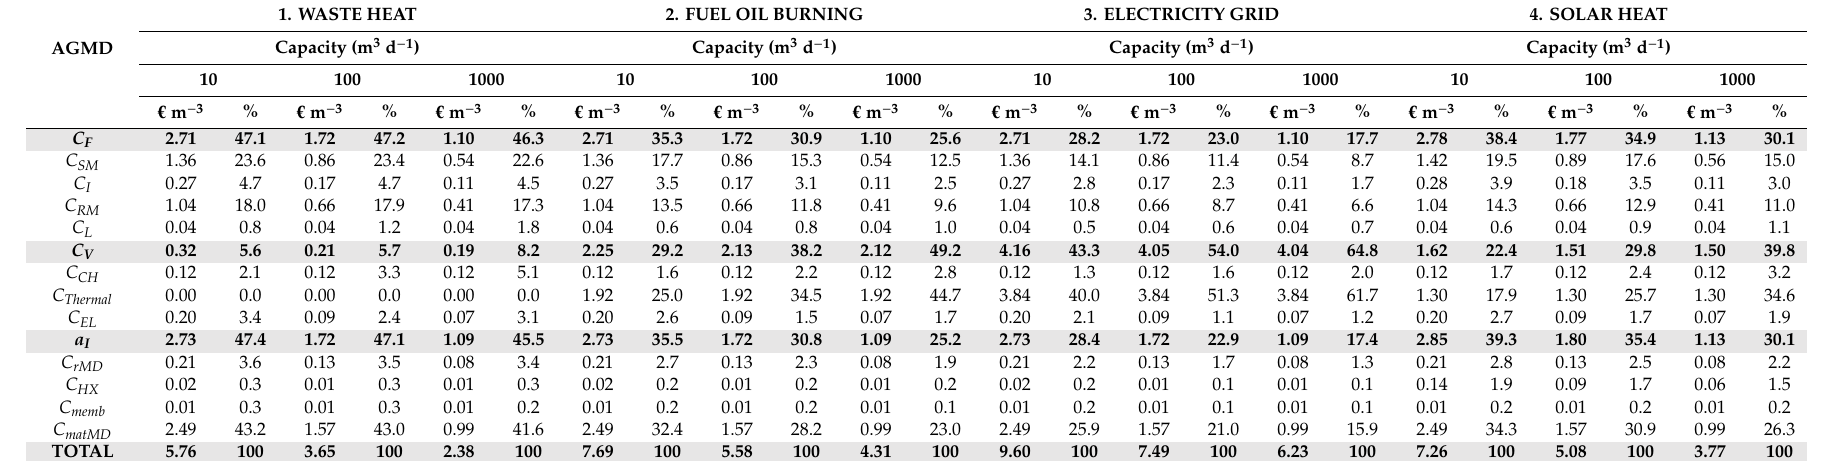
Table 5. Influence of the di ff erent AGMD costs on the SCOW. Costs are expressed in € m − 3 and % for each capacity and scenario considered.